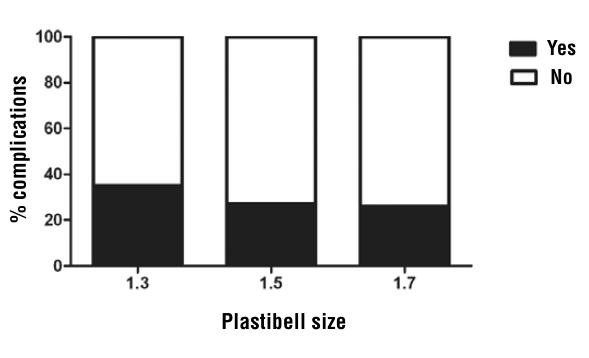
Figure 3 - Complications according to the size of